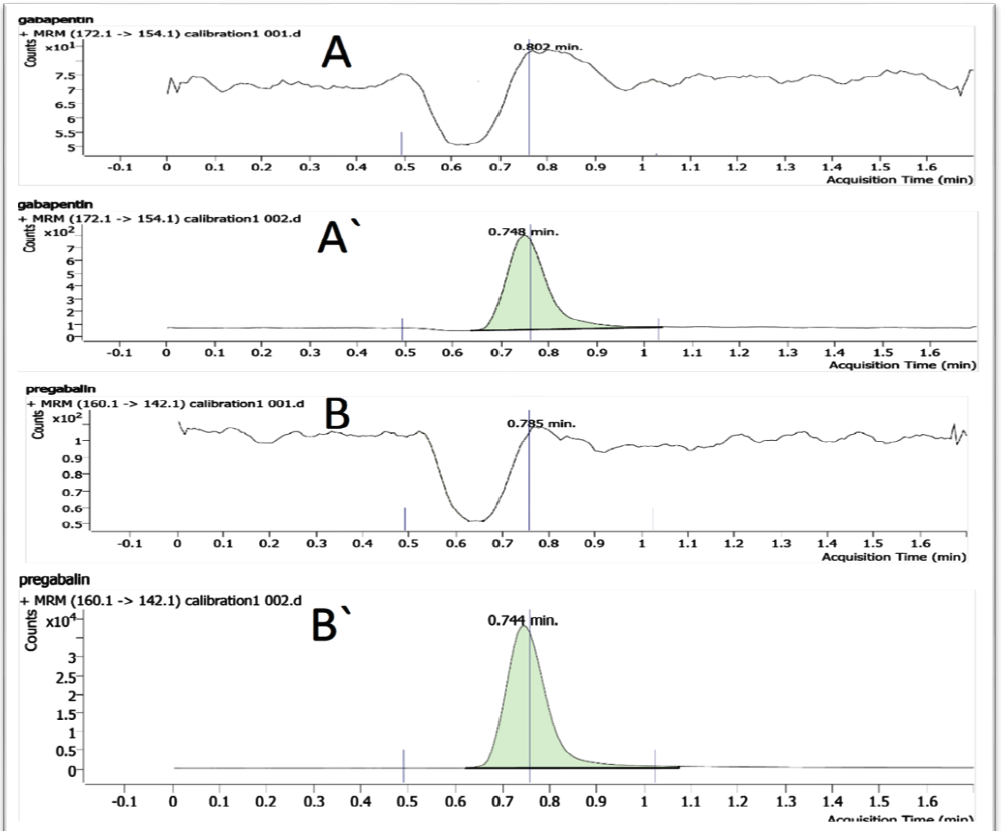
Figure 4. Mass chromatograms of plain plasma ( A ), plasma enriched with GAB in LOQ sample ( A’ ), PRE ( B ) IS blank sample and PRE peak at LOQ sample ( B’ ).